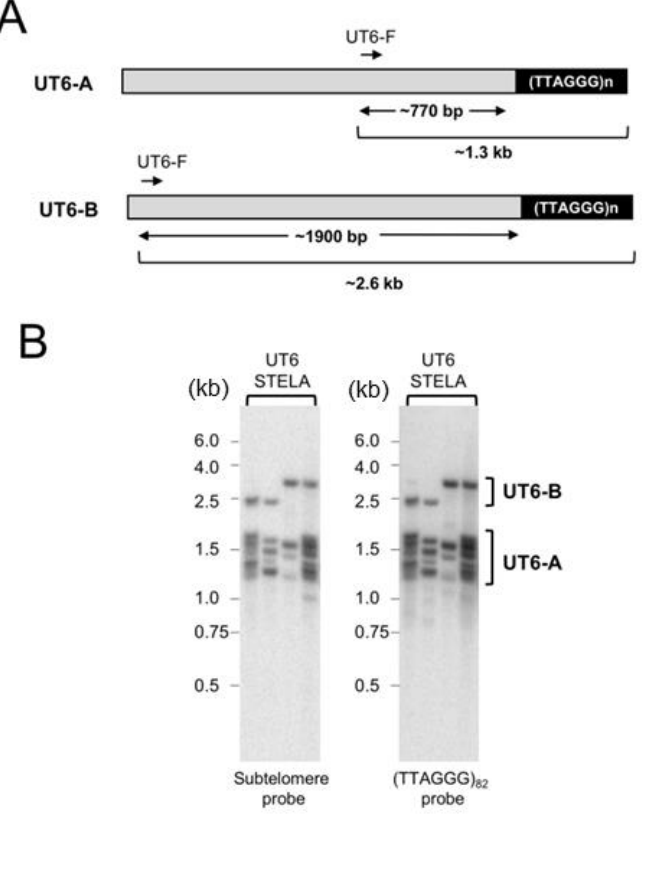
FIGURE 2: STELA analysis of UT6-containing telomeres. (A) Schematic illustration of two classes of UT6- containing telomeres in U. maydis . Note that the 770 bp estimate for UT6-A subtelomeres is based on our cloning and sequencing of STELA products and is considerably longer than the previously reported 519 bp estimate. (B) STELA assays were performed using wild type DNA as well as the UT6-F and teltail primers. Following gel elec- trophoresis and transfer to a nylon membrane, the products were first detected using a UT6 subtelomeric probe (left panel). Subsequently, the UT6 probe was stripped from the membrane and the products re- analyzed using a TTAGGG repeat probe (right